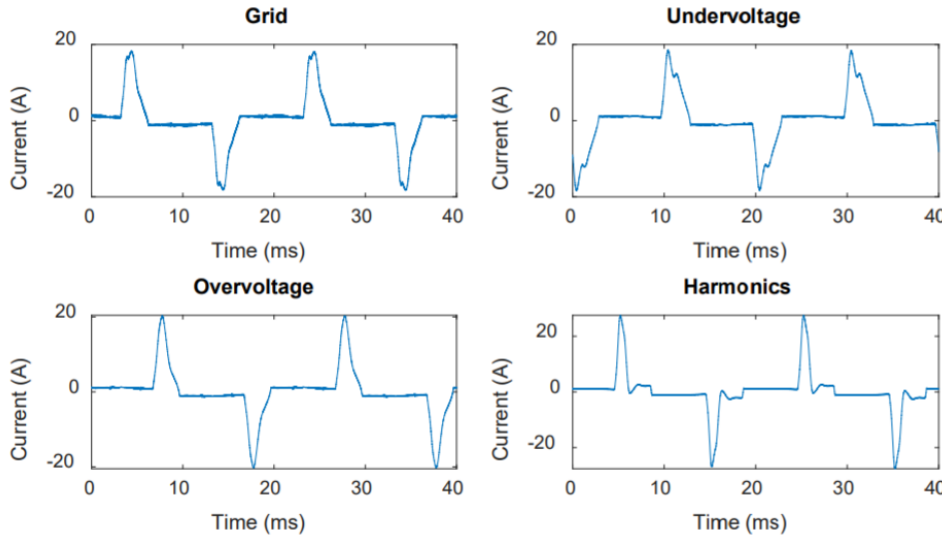
Figure 5. Current profile for four identical groups of lamps fed by different voltage